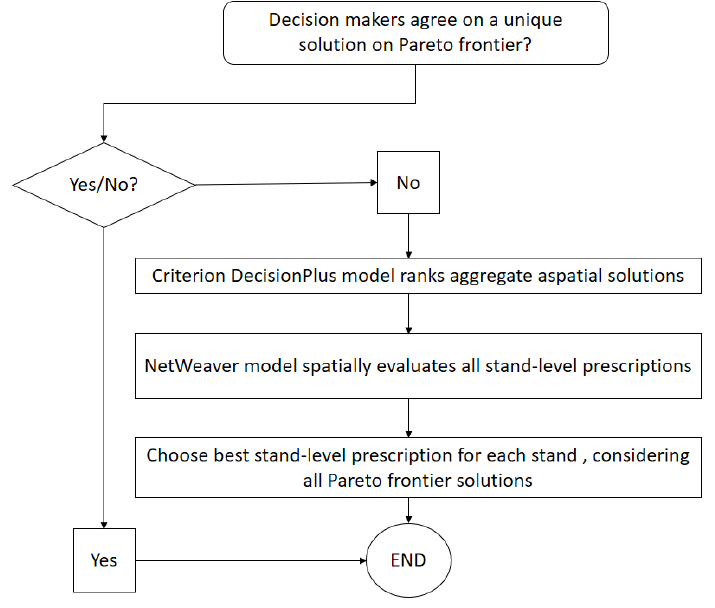
Figure 2. Decision support flowchart.